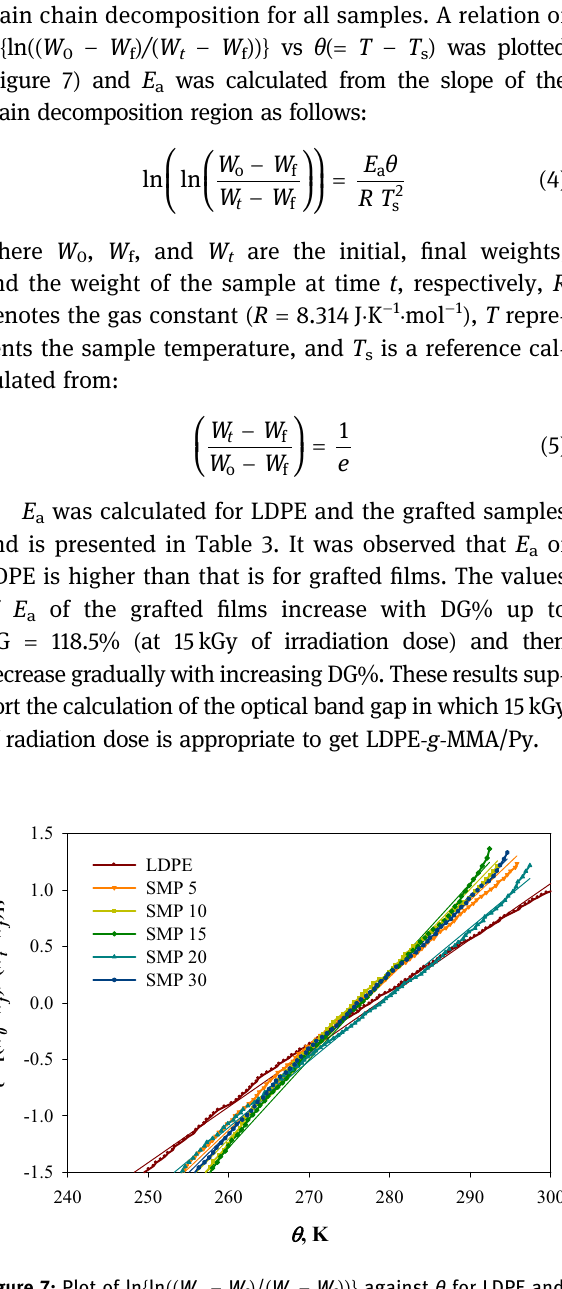
Figure 7: Plot of ln { ln (( W 0 − W f ) / ( W t − W f ))} against θ for LDPE and LDPE - g -